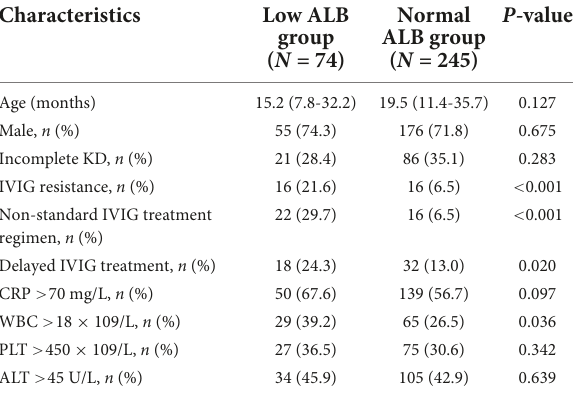
FIGURE3 Incidence of coronary artery lesion progression among Kawasaki disease patients. The low ALB group: albumin level < 30 g/L. The normal ALB group: albumin level ≥ 30 g/L. CALs, coronary artery lesions; ALB, albumin level.